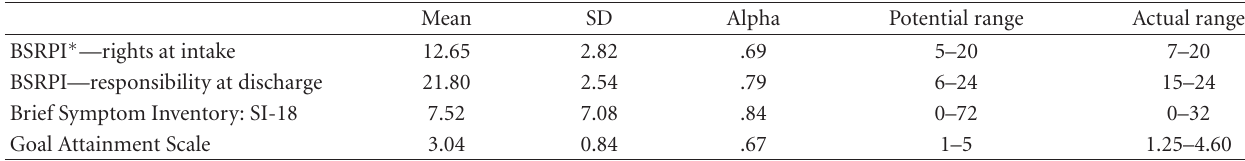
Table 1: Summary statistics of the study scales.